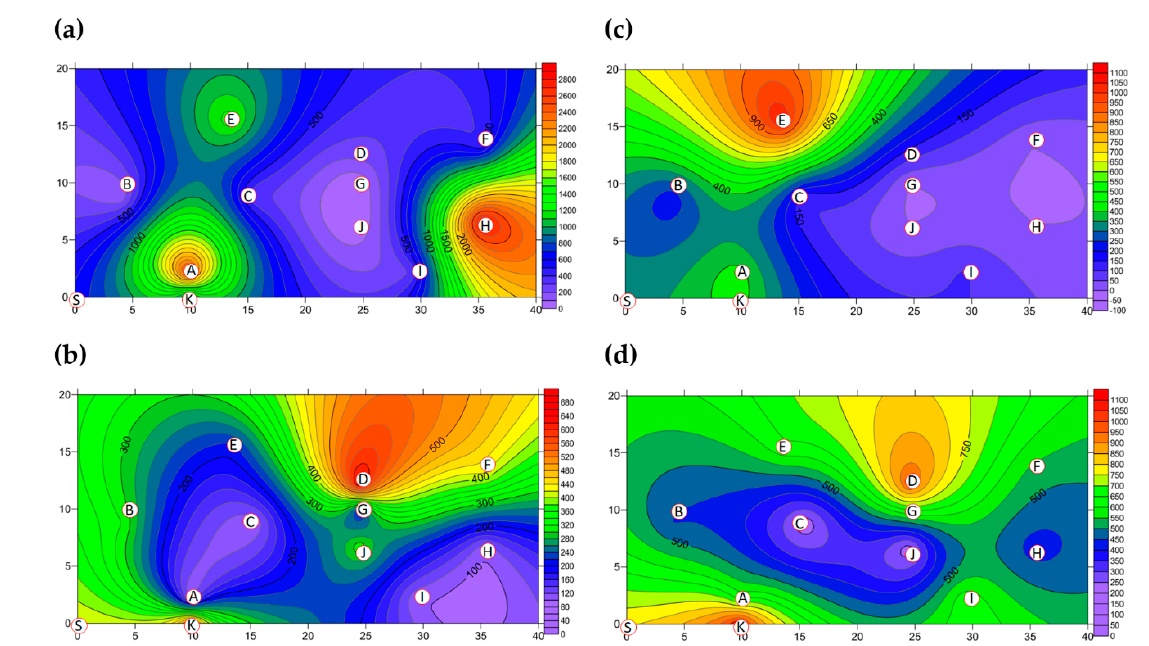
Figure 5. The bacterial bioaerosols (BBs) (CFU m − 3 ) present as ( a ) LPBs and ( b ) SPBs in Market A before operations commenced and the concentrations of ( c ) LPBs and ( d ) SPBs present after opera- tions had finished. Red circular dots with English titles show sampling locations. Bioaerosols in the white area had values below the scale.